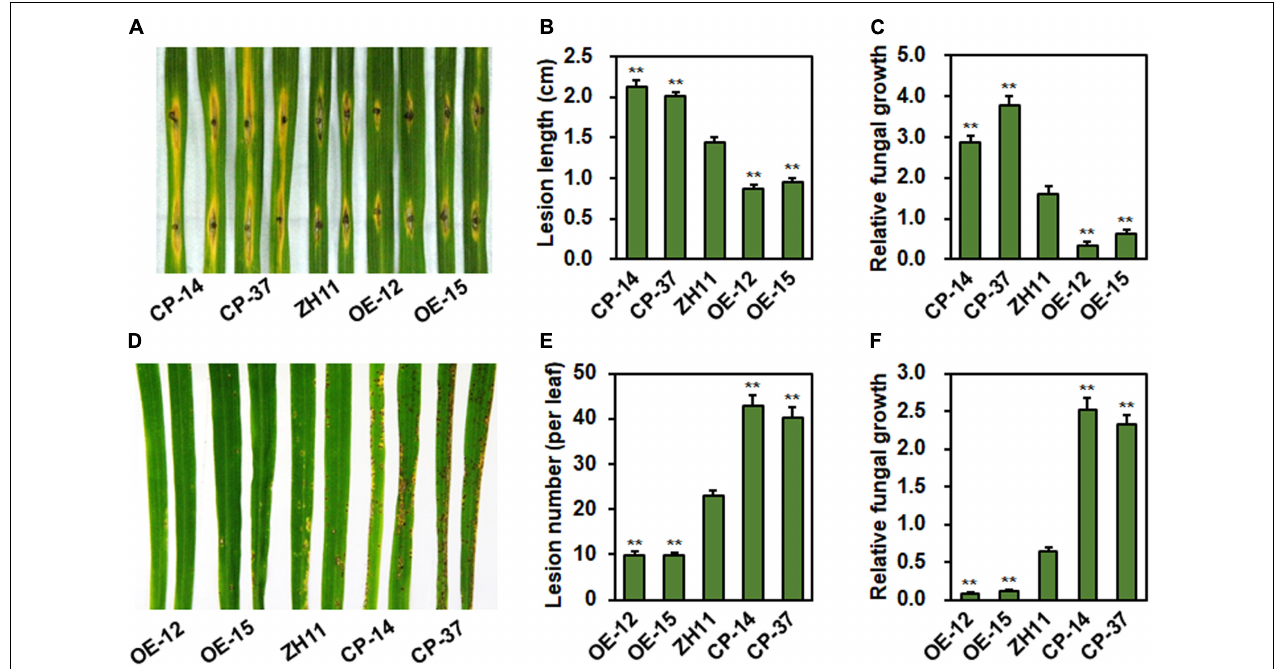
FIGURE 3 | ONAC096 positively regulates rice resistance against M. oryzae . (A–C) Disease symptom (A) , lesion length (B), and relative fungal growth (C) in the representative leaves of ONAC096 -CP and ONAC096 -OE plants. (D–F) Disease symptom (D) , lesion number (E) , and relative fungal growth (F) in the representative leaves of ONAC096 -OE and ONAC096 -CP plants. Detached leaves from 4-week-old plants were inoculated by dropping 5 µ L spore suspension of M. oryzae (5 × 10 5 spores/mL) (A) or 4-week-old plants were inoculated by foliar spraying of spore suspension of M. oryzae (2 × 10 5 spores/mL) (D) . Images were taken and leaf samples were collected at 5 dpi. Relative fungal growth was presented as folds obtained by genomic qRT-RCR analyzing of the M. oryzae MoPot2 gene level with the rice OsUbq gene level. Experiments were repeated at least three times with similar results, and results from one representative experiment are shown in panels (A,D) . Data presented (B , C , E , F) are the means ± SE from three independent experiments and asterisks indicate significant difference ( p < 0.01, Student’s t test) in comparison to